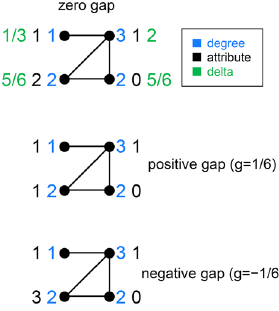
Figure 4. An anti-SGFP graph such as this may produce differently-signed gaps for r d , a = 0 , depending on the attribute